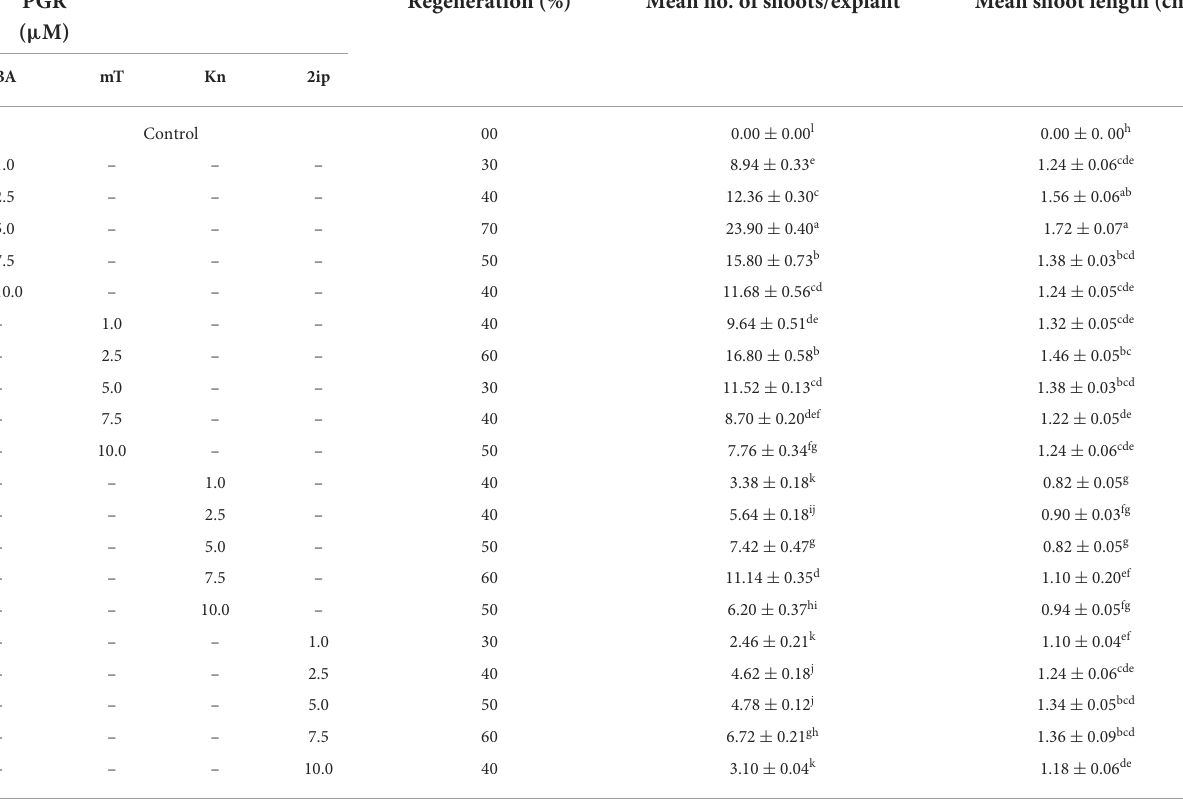
DifferentlettersinthesamecolumnaresignificantlydifferentatP ≤